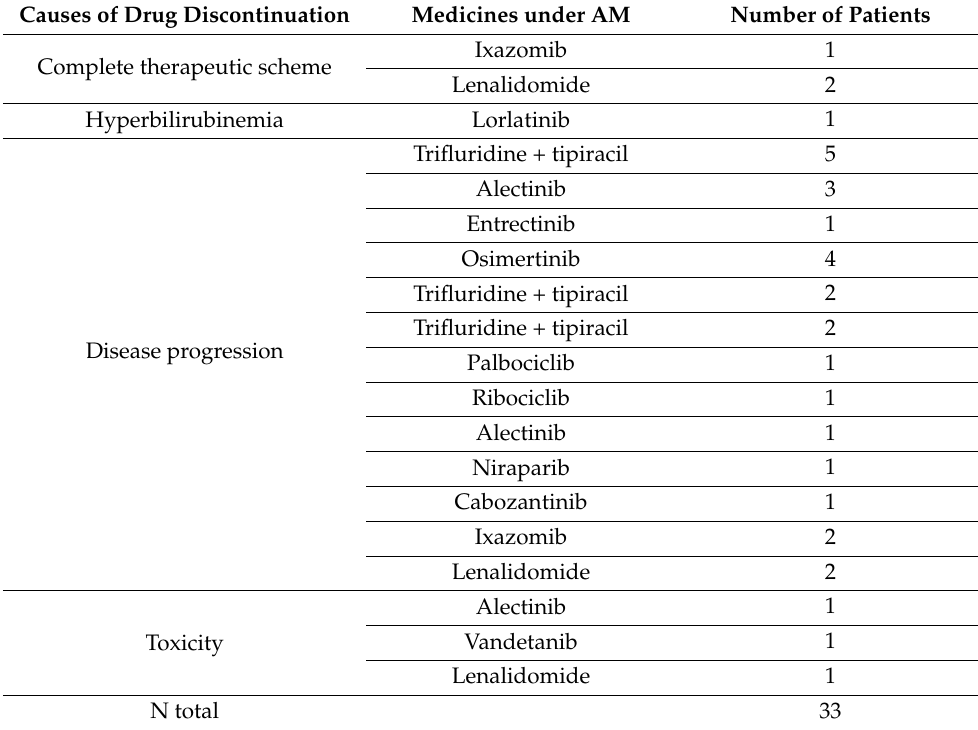
Table 5. Causes of discontinuation according to the prescribed